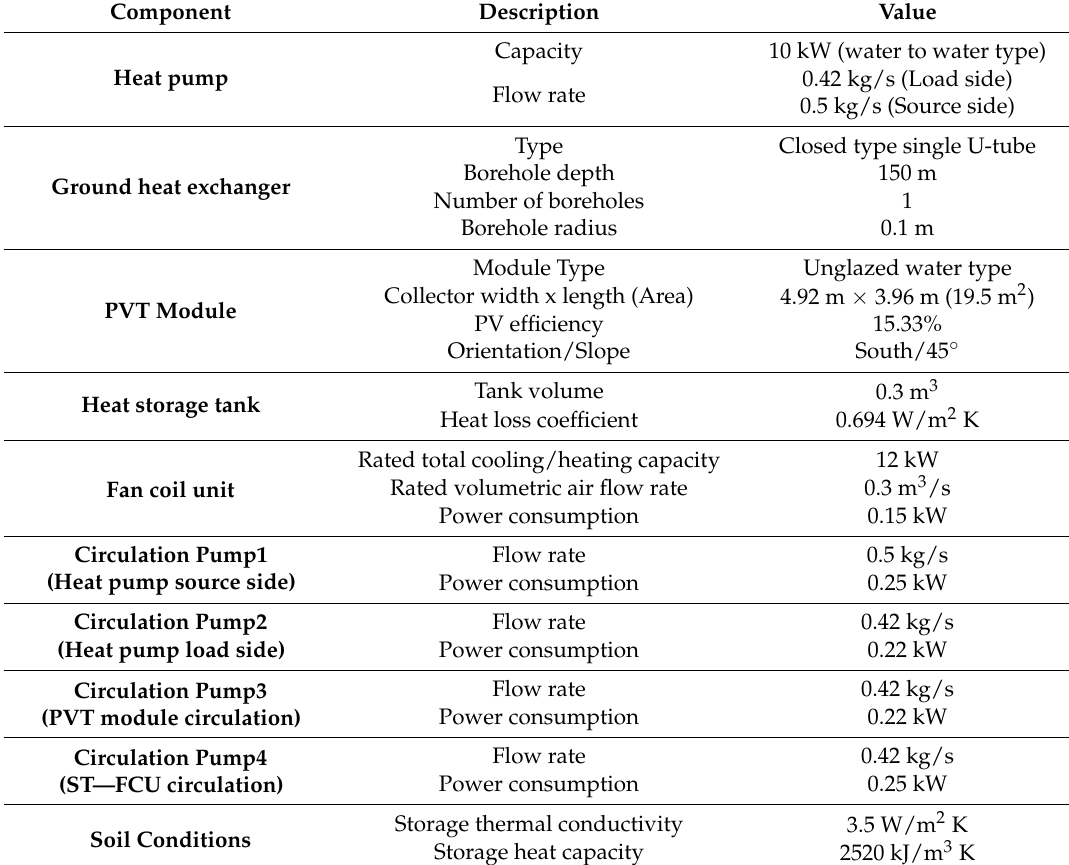
Table 2. The parameters of Geo-PVT system in rated